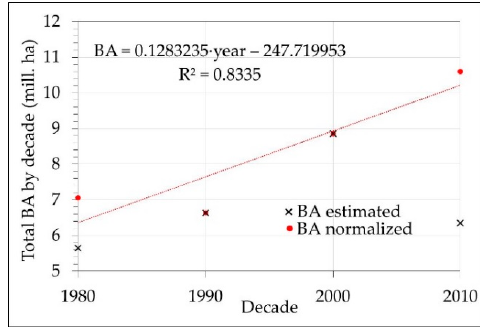
Figure 4. Estimated and normalized decadal LTDR Burned Area for the Northeastern Siberia boreal region and the estimated linear trend.